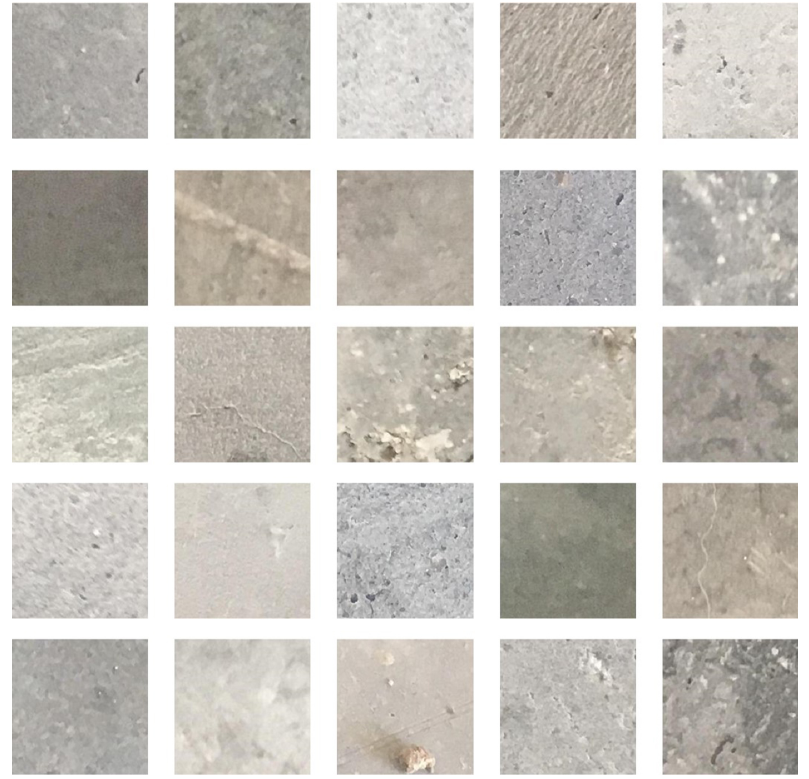
Figure 7. The concrete crack dataset that does not contain the images of the